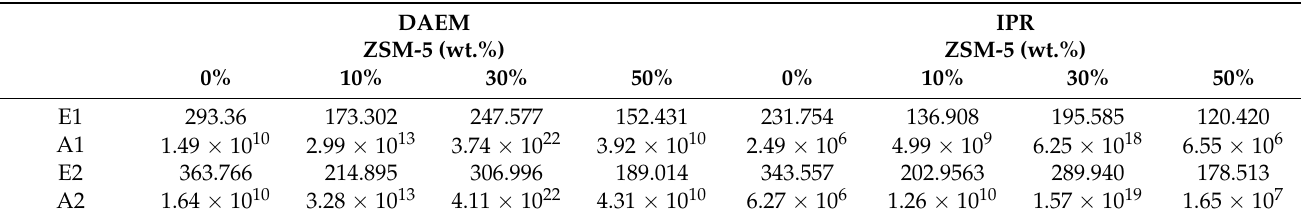
Table 4. The pyrolysis characteristic parameters for MFPW and ZSM-5 (30%)/MFPW samples at 5 and 30 ◦ C/min.